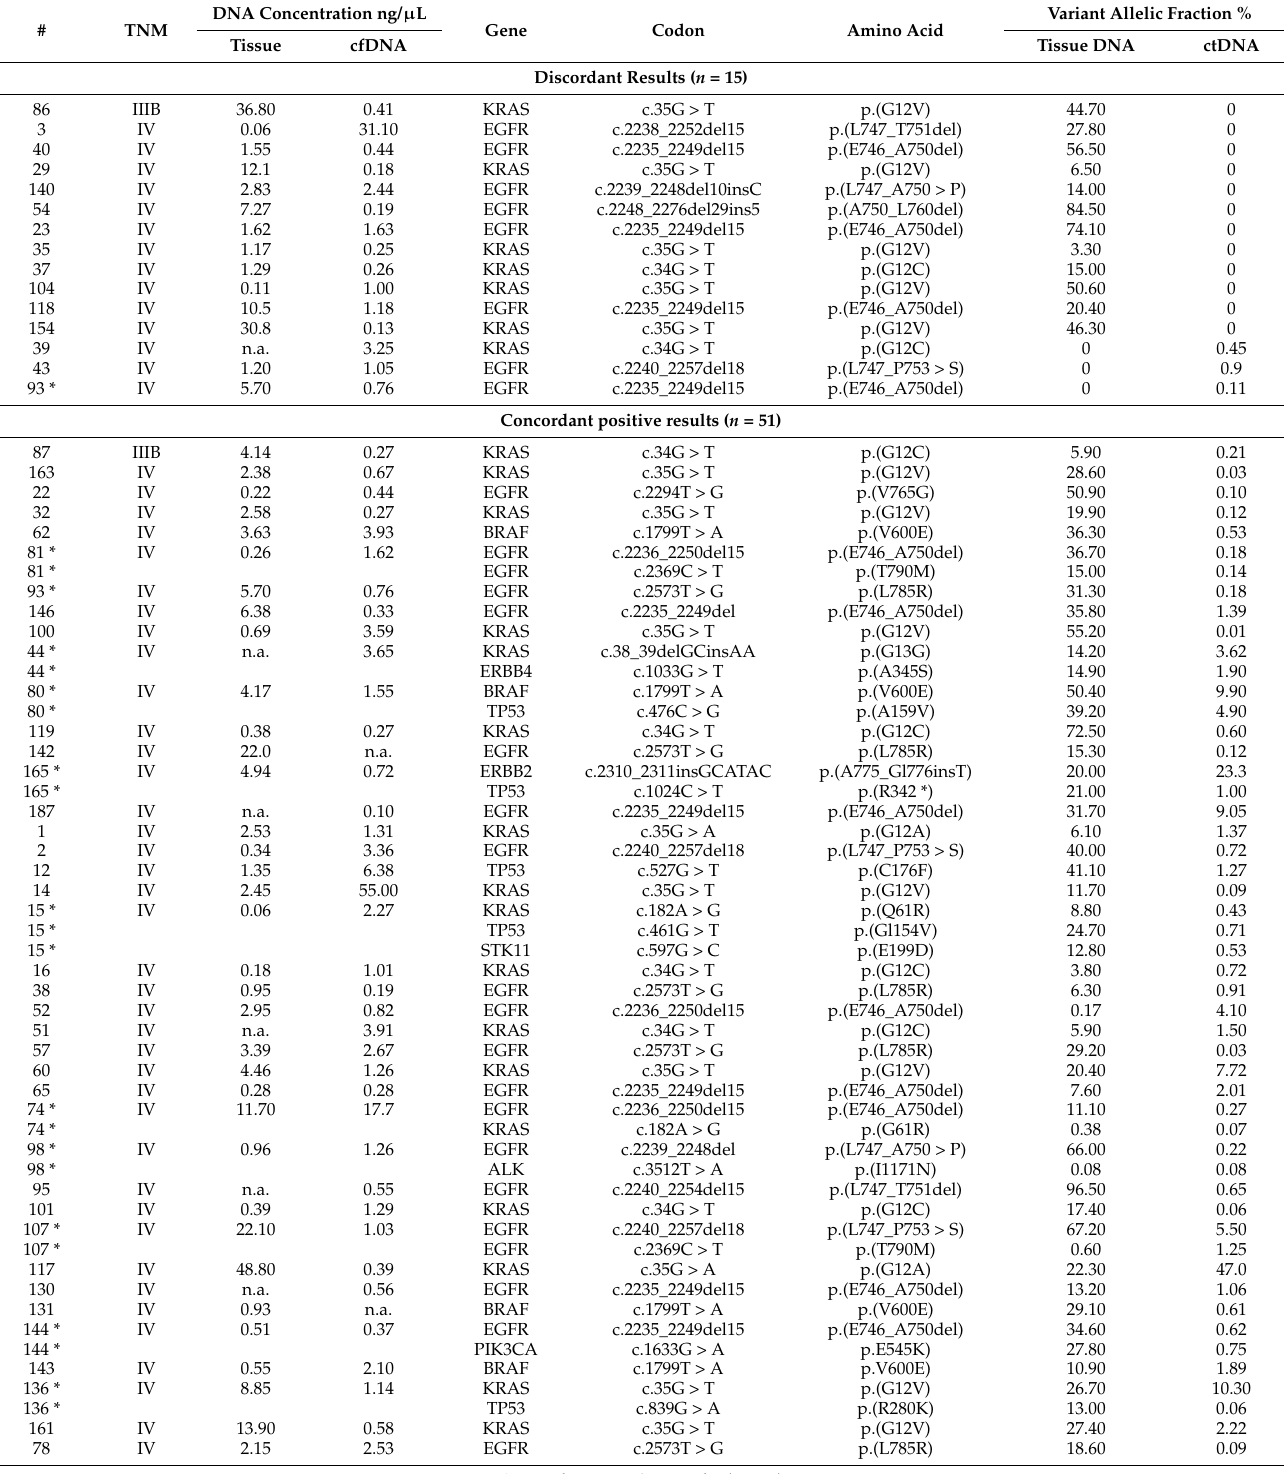
Table 2. Comparison between ctDNA and tissue